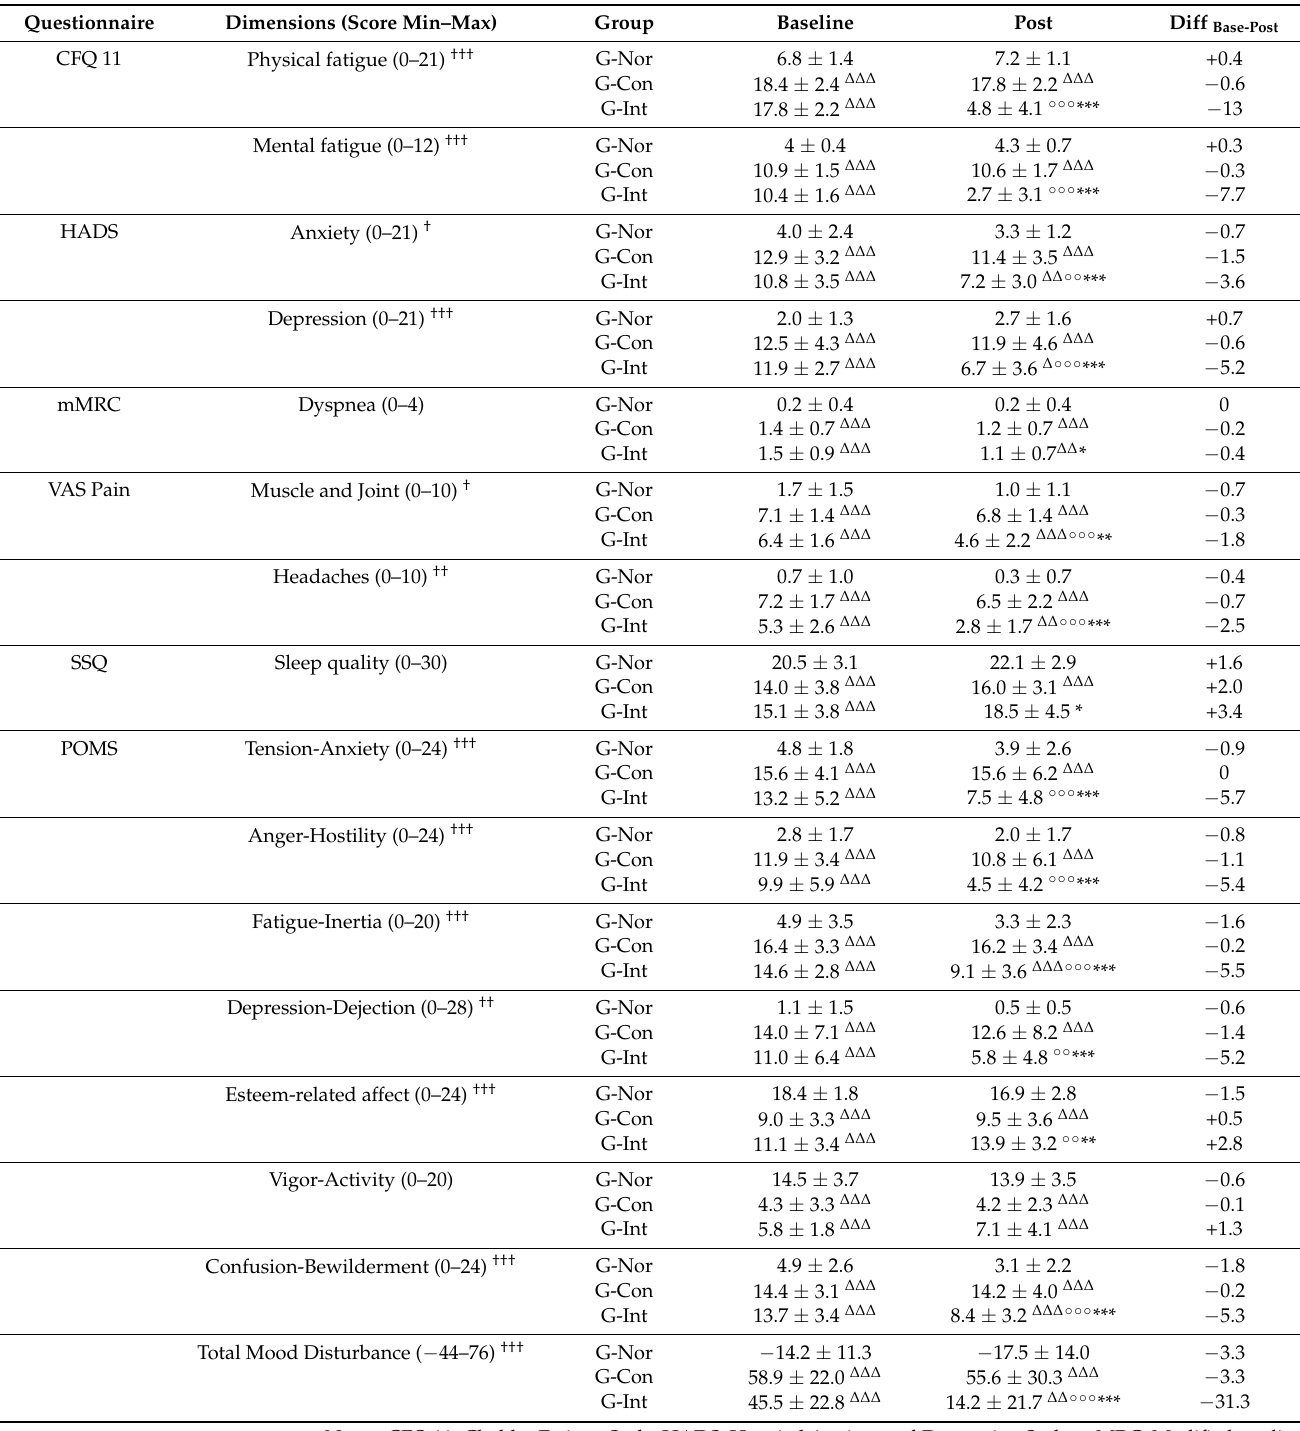
Table 2. Summary of the psychometric assessment results